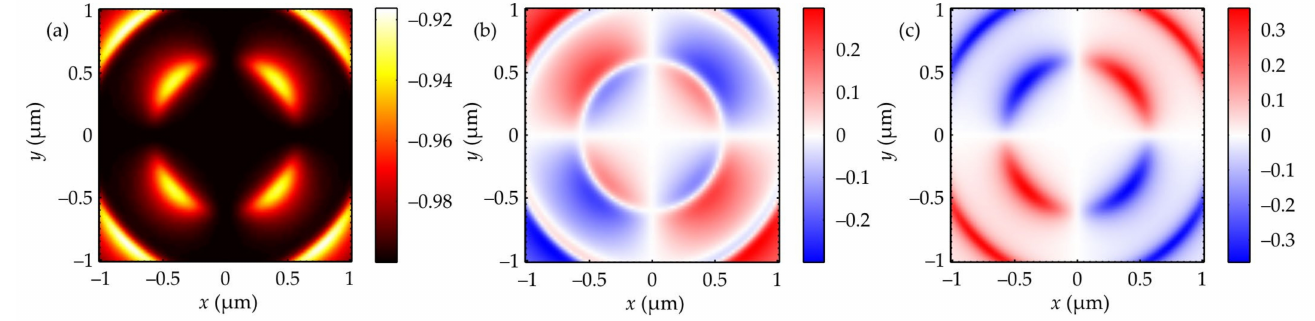
Figure 9. Distribution of the components of the normalized Stokes vector S 1 ( a ), S 2 ( b ) and S 3 ( c ) for a lens with a numerical aperture NA =